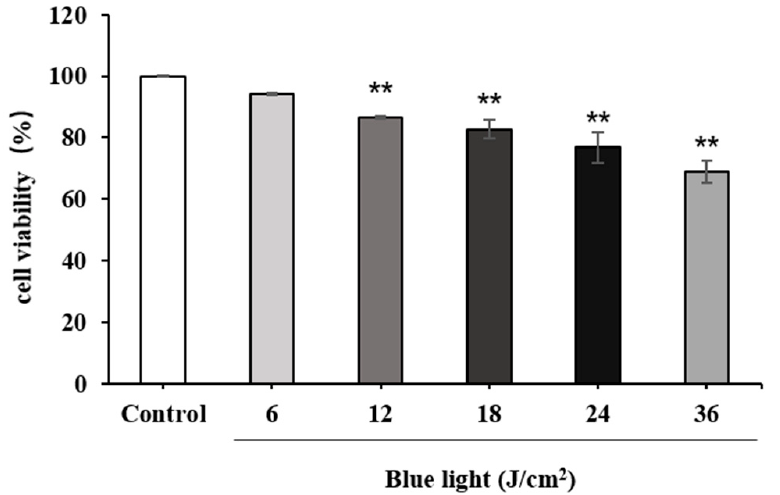
Figure 3. Effects of different doses of blue light on human foreskin fibroblast (HFF) cell viability. The data are expressed as mean ± standard deviation (SD) of three independent experiments ( n = 3). The data were analyzed using one-way analysis of variance (ANOVA) followed by Tukey’s test. ** p < 0.05, versus cells without blue light treatment.